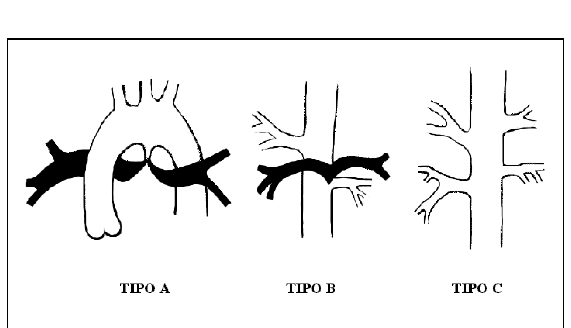
Fig. 4 – Classificação de atresia pulmonar com comunicação interventricular, segundo BARBERO MARCIAL